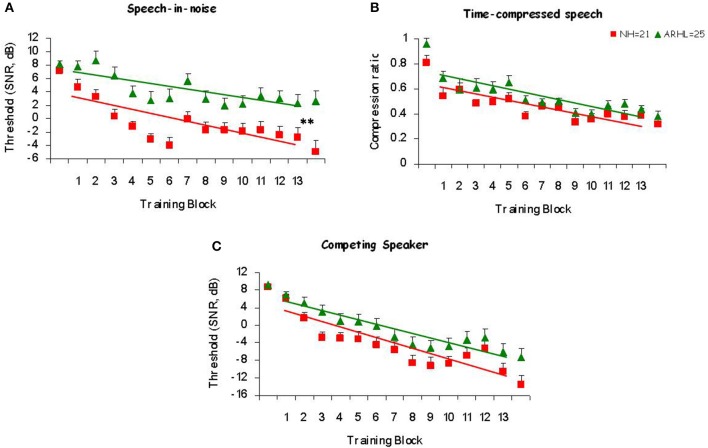
Learning curves. Mean thresholds as a function of the trained block for trained Normal-Hearing (NH) and trained Age-Related Hearing Loss (ARHL) participants in (A) Speech-in-noise (B) Time-compressed speech and (C) Competing speaker conditions. Mean signal-to-noise ratio (SNR) thresholds of each block was used as the dependent measure in speech-in-noise and competing speaker conditions and the compression ratio was used for the time-compressed speech condition. Regression lines and slopes of the learning curves (A) for trained NH are shown in red and for trained ARHL in green. **p < 0.01.